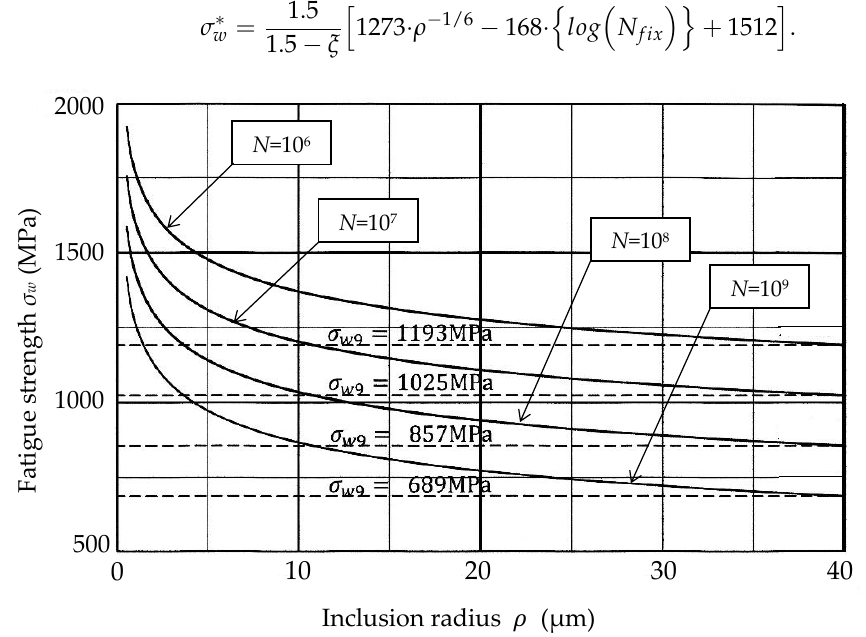
Figure 10. σ w - 𝜌 relationships at several given numbers of stress cycles. Figure 10. σ w - ρ relationships at several given numbers of stress